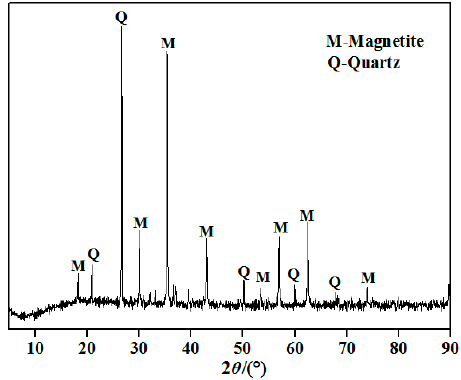
Figure 2. X-ray diffraction pattern for the studied magnetite iron ore.